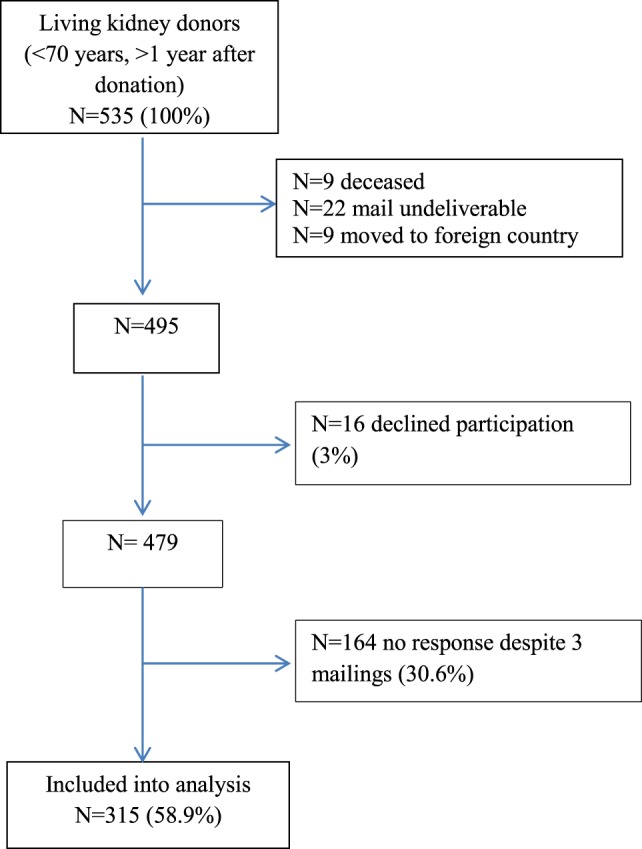
Study flow chart.